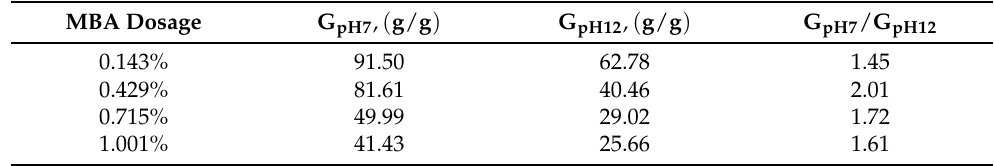
Table 4. The saturated absorption rates of SAPs prepared with different MBA dosages tested at 90 ◦ C in water (pH = 7) and in NaOH solution (pH = 12), and the pH-sensitive index. MBA Dosage G pH7 , ( g / g ) G pH12 , ( g / g ) G pH7 / G pH12 0.143% 91.50 62.78 1.45 0.429% 81.61 40.46 2.01 0.715% 49.99 29.02 1.72 1.001% 41.43 25.66 1.61